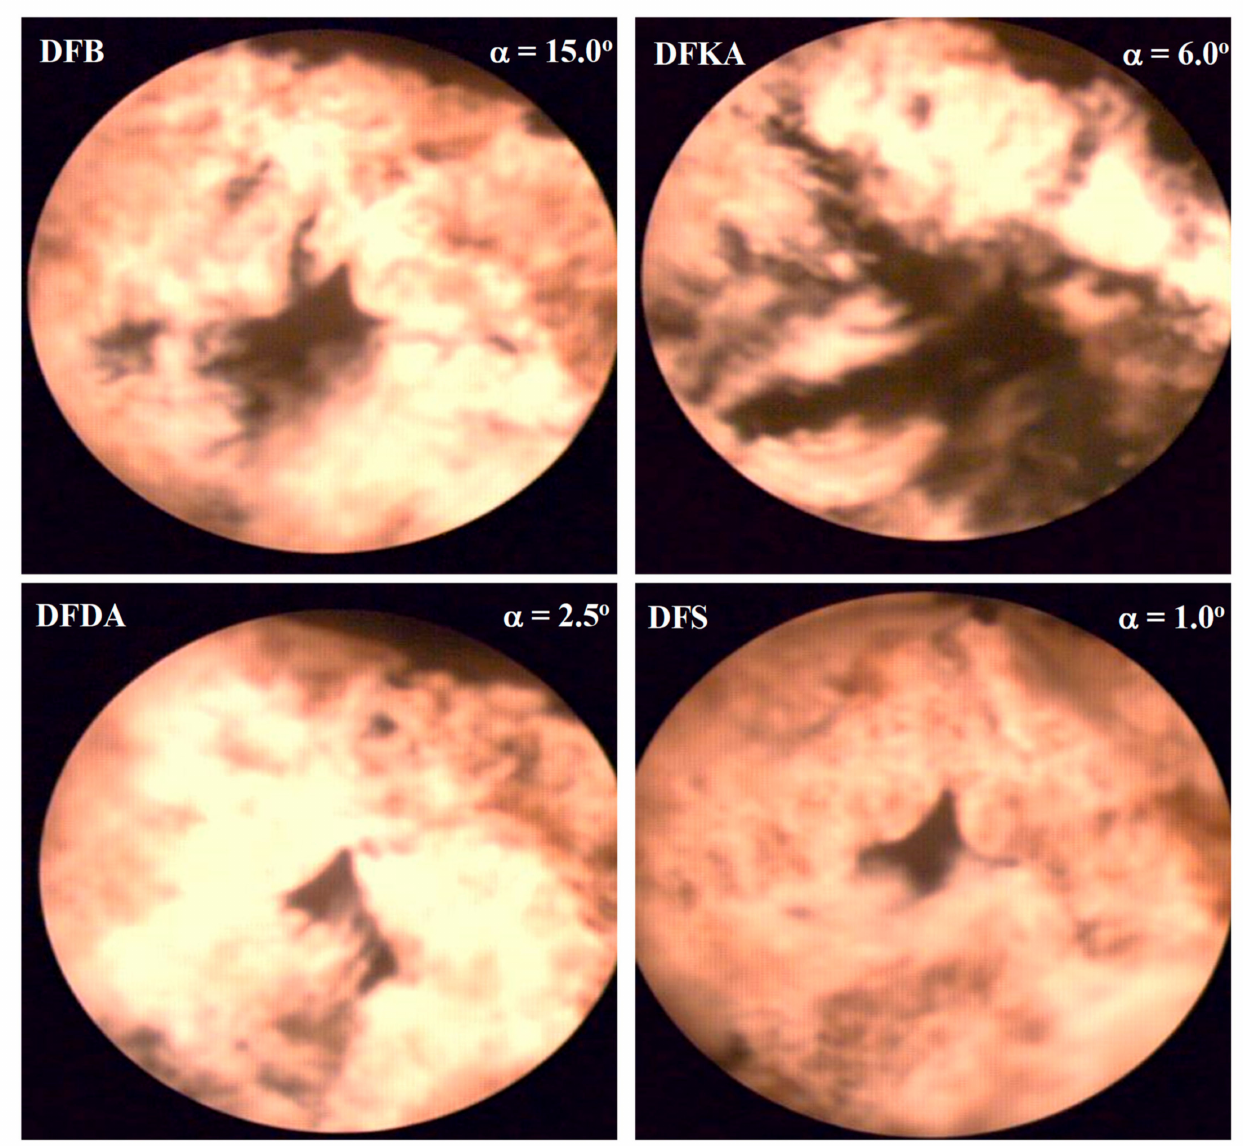
Figure 31. Image inside engine cylinder for crankshaft angle of rotation corresponding to maximum speed of diffusion combustion α dQd_max